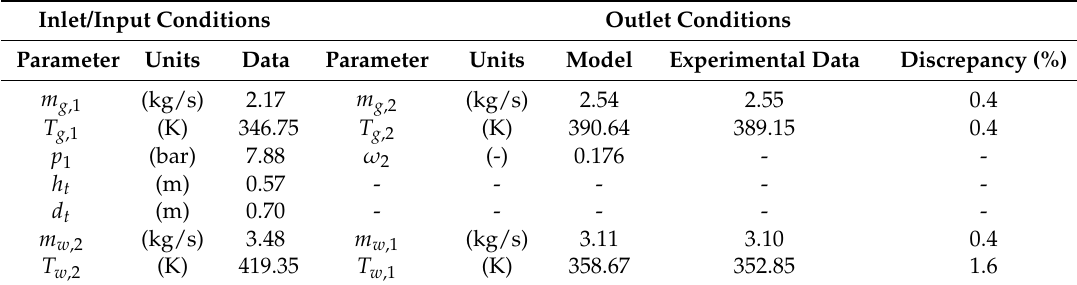
Table A2. ValidationoftowerpackingheightcalculationagainstexperimentaldatafromLindquist et al.